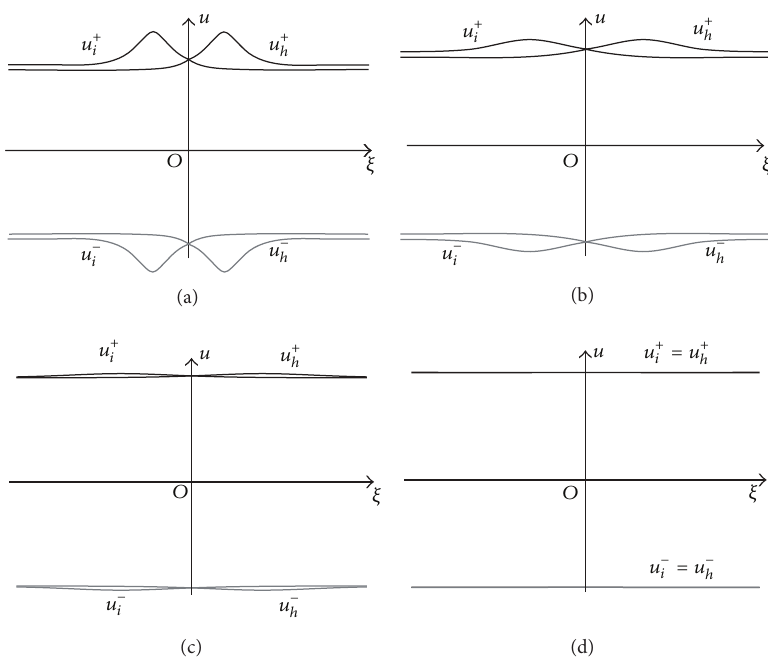
Figure12:Foursymmetricsolitarywavesbecometwotrivialwaves.Thevaryingprocessforthefiguresof 𝑢 ± ℎ and 𝑢 ± 𝑖 when 𝑏 → −(5𝑎 2 /36𝑐)+0 , where 𝑐 = 𝑎 = 𝜔 = 1 , 𝛾 = 𝛿 = −1 , and (a) 𝑏 = −(5𝑎 2 /36𝑐) + 10 −2 , (b) 𝑏 = −(5𝑎 2 /36𝑐) + 10 −3 , (c) 𝑏 = −(5𝑎 2 /36𝑐) + 10 −4 , and (d) 𝑏 = −(5𝑎 2 /36𝑐) + 10 −6